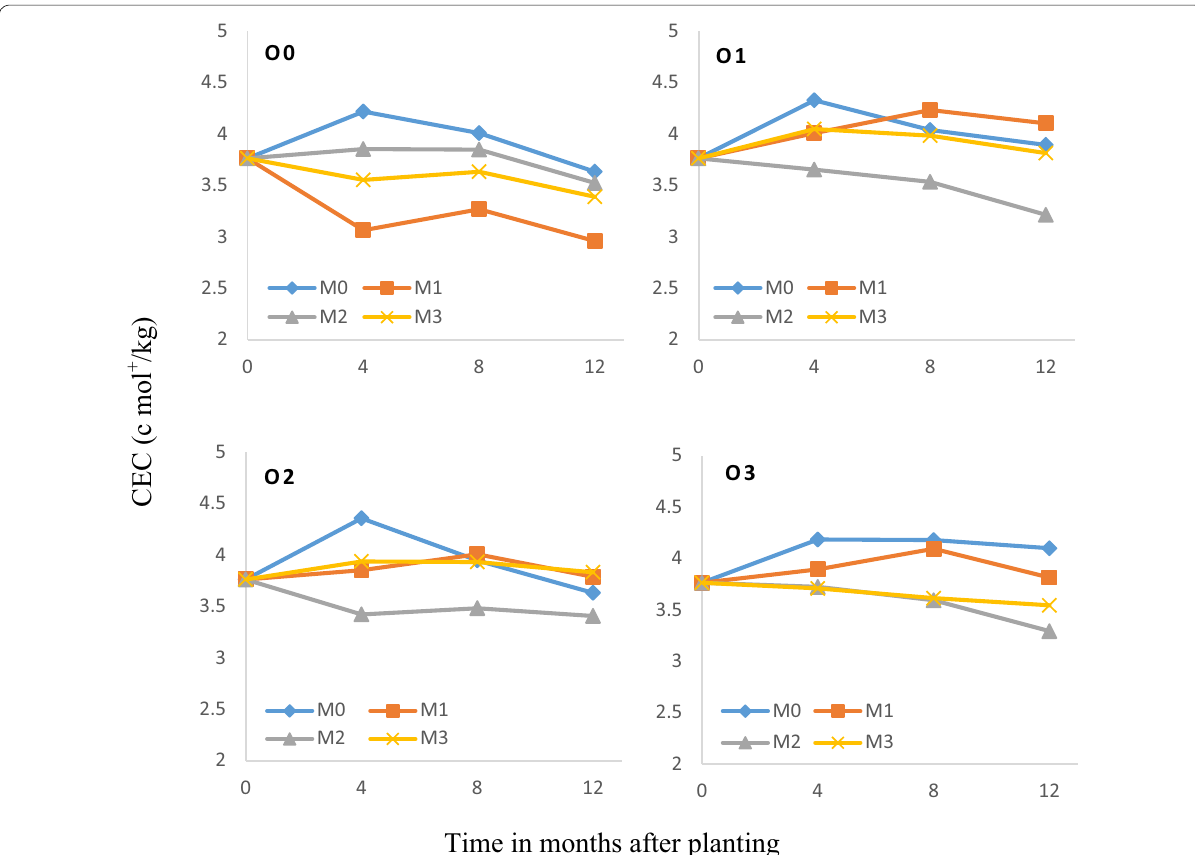
Fig. 3 The interaction effect between organic and mineral fertilizer on soil